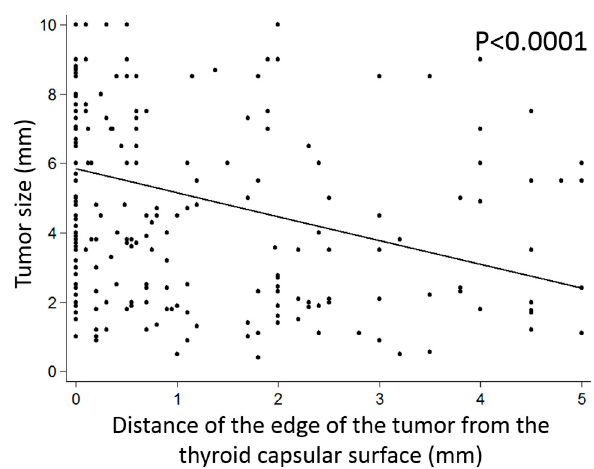
Figure 3. Relationship of the tumor size with the distance of the edge of the tumor from the thyroid capsule. Small microcarcinomas are preferentially located away from the capsule (linear regression, p < 0.0001).